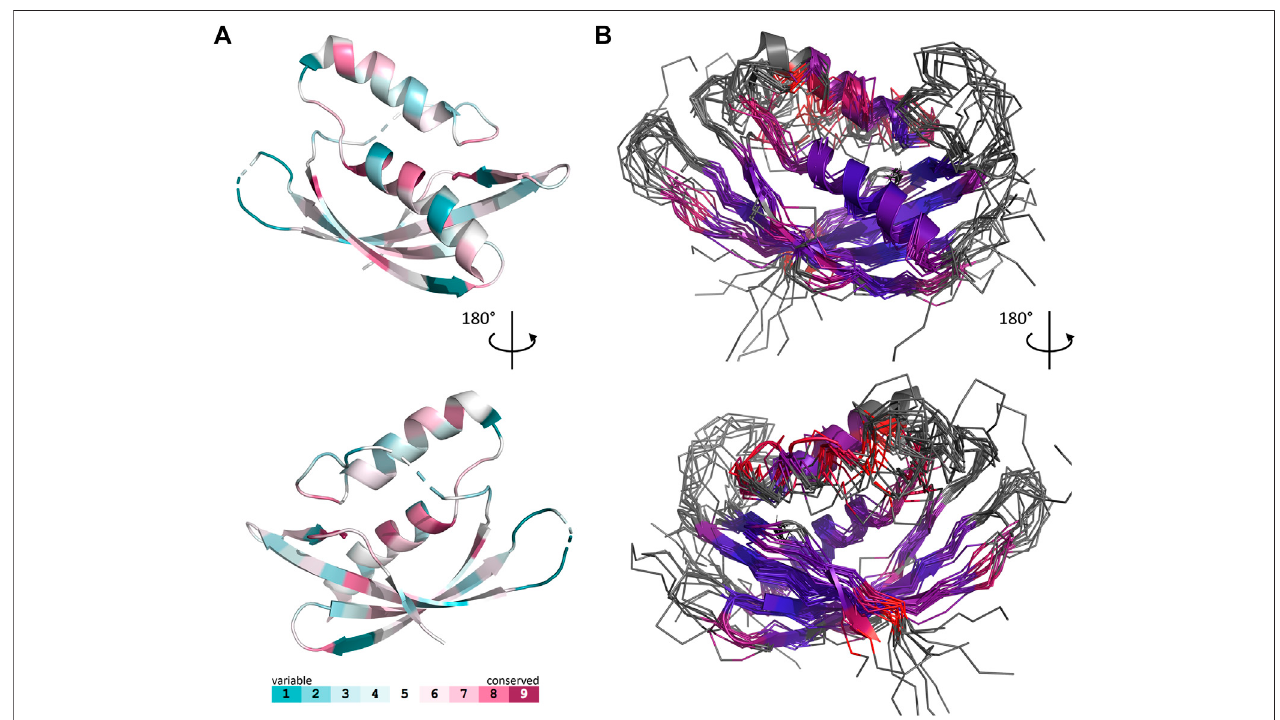
FIGURE 3 | Comparison of 17 representative three-dimensional structures of VirB8 and VirB8-like proteins. The structure of OrfG 64 – 204 (PDB id 6zgn) is represented as a cartoon (A) , with its amino acids colored according to the Consurf server (Ashkenazy et al., 2016) which analyzed the similarity calculated in the sequence alignment deduced from the structure superposition produced by mTM-Align (Dong et al., 2018a) for a set of sventeen selected proteins. The amino acid shown with sticks (Val191 in OrfG) and localised in β 4 facing α 1 is the only one whose side chain shares asimilar nature in all structures, while there isno conserved residue. The 17 structures (PDB ids 2cc3, 3ub1 (limited to TcpC 104 – 231 ), 3wz3, 3wz4, 4akz, 4ec6, 4jf8, 4kz1, 4lso, 4mei, 4nhf, 4o3v, 5aiw, 5cnl, 5i97, 6iqt, 6zgn) are represented (B) as superposed wires (except OrfG as a cartoon) using a color-code based on the quality of the superposition of these structures. For each position, a gradient from violet to red is used depending on the low to high values of the root mean square calculated on the distance between all the possible pairs of the 17 superposed C α carbons at this position (grey means that mTM-Align found at least one structure impossible to align). This representation highlights the resemblances and differences in the NTF2-like folds of these